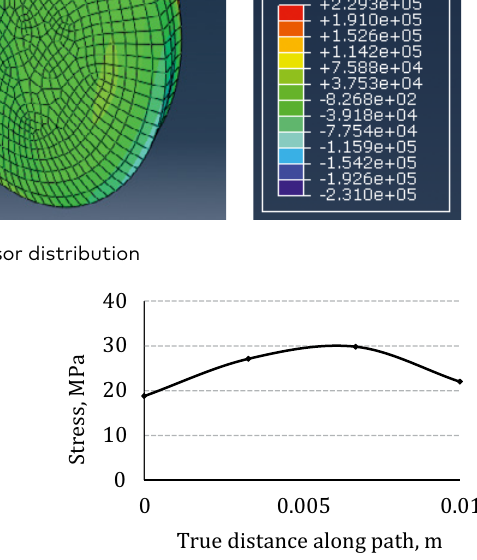
Figure 6. FEM simulation for Modified Leutner Shear